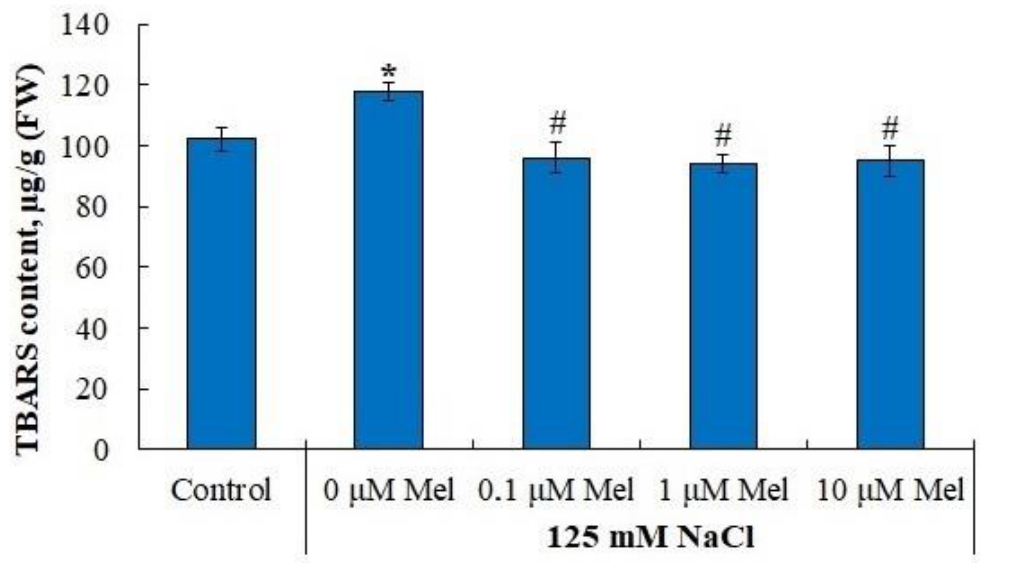
Figure 5. Influence of melatonin and chloride salinity on TBARS content in Solanum tuberosum leaves. Asterisks (*) indicate significant differences from the control variant and the «#» indicates significant differences from the «125 mM NaCl» variant ( p < 0.05).